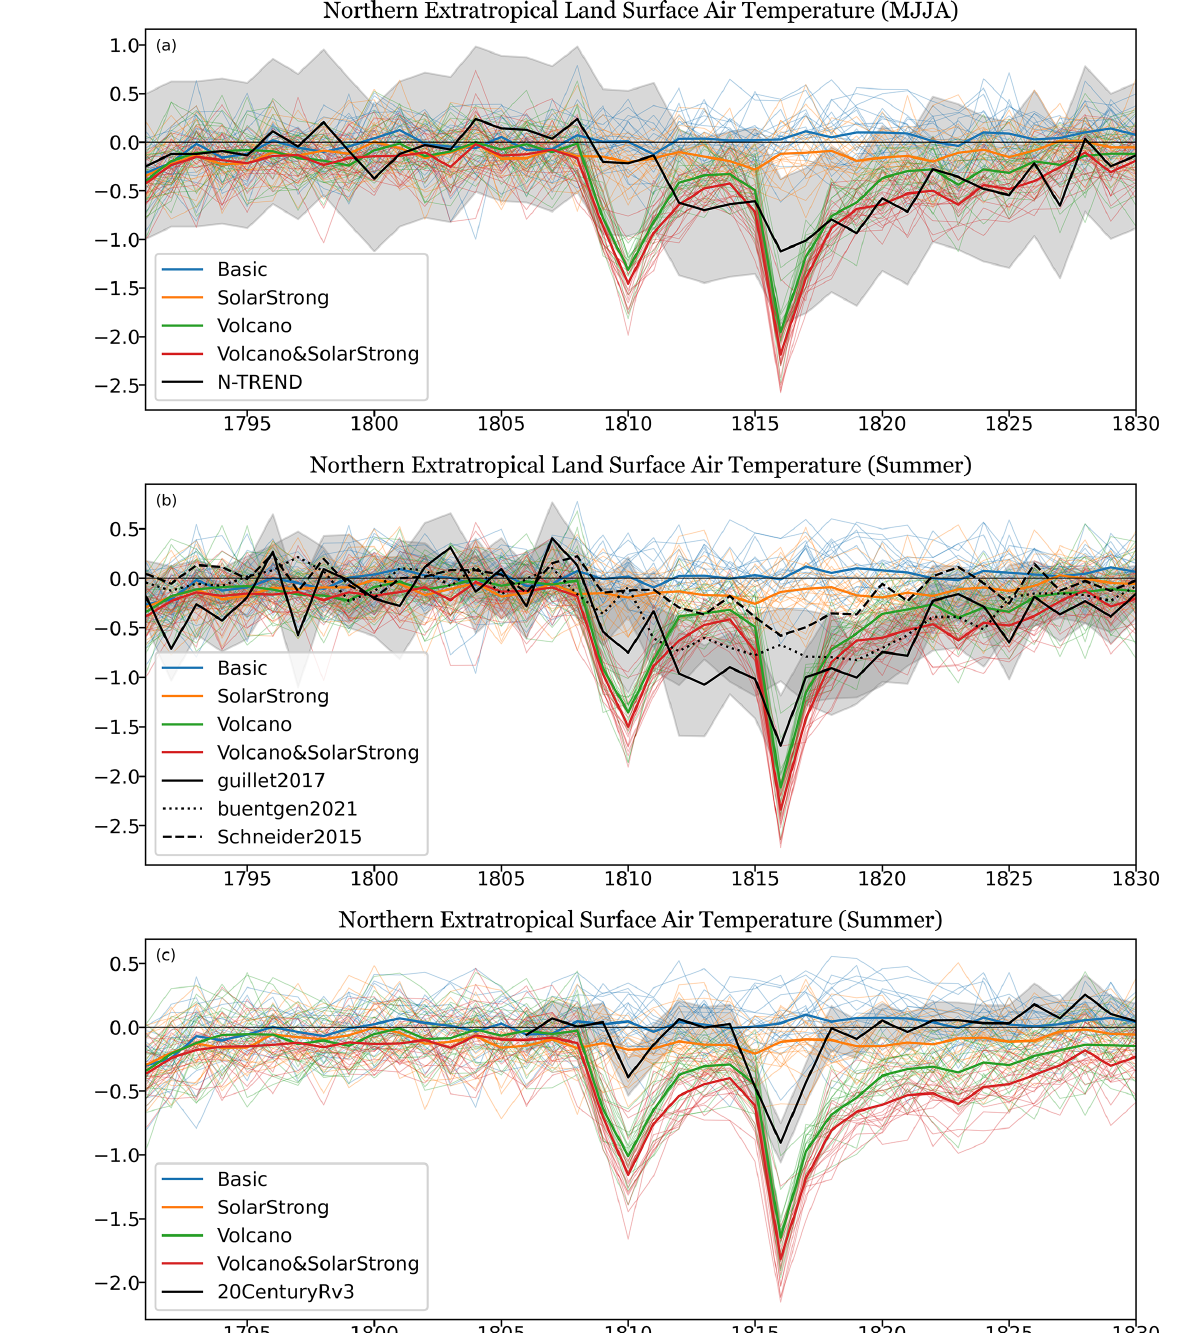
Figure 12. (a) Northern extratropical (30 to 90 ◦ N) May to August land surface air temperature anomalies for Basic (blue), SolarStrong (orange), Volcano (green), and Volcano&SolarStrong (red) experiments, (b) for northern extratropical summer land surface air temperature and (c) for northern extratropical summer surface air temperature. The black lines are for the anomalies from reconstruction projects and the gray shadings are the uncertainties. The reconstruction anomalies are offset with the difference from the ensemble mean of the Basic experiment over 1800–1808 for lining with the Basic experiment. In (a) , the uncertainty of the N-TREND (Wilson et al., 2016) is provided in the dataset. In (b) , the uncertainty of guillet2017 (solid; Guillet et al., 2017) is provided in the dataset and the uncertainty for the buentgen2021 is calculated by the one standard deviation of the 15 ensemble members (R1 to R15; dotted; Büntgen et al., 2021). Schneider2015 is